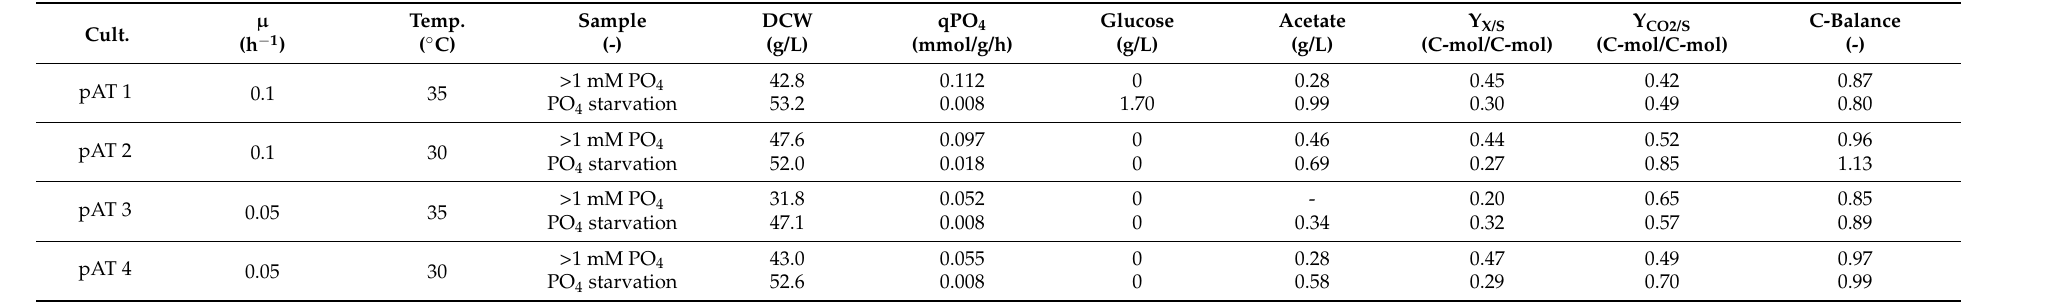
Table 4. Strain physiological parameters for pAT